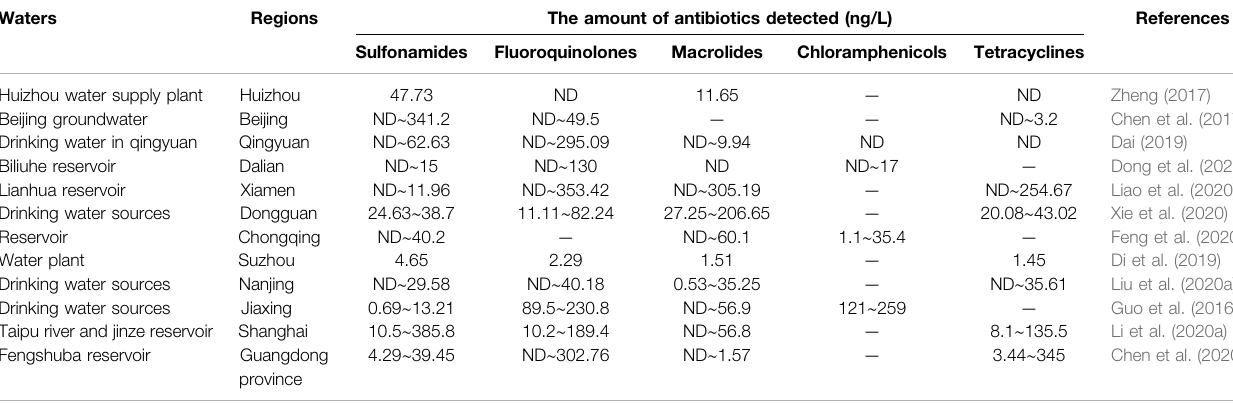
TABLE 4 | Antibiotic concentrations in drinking water sources in some cities (From 2015 to 2020). Waters